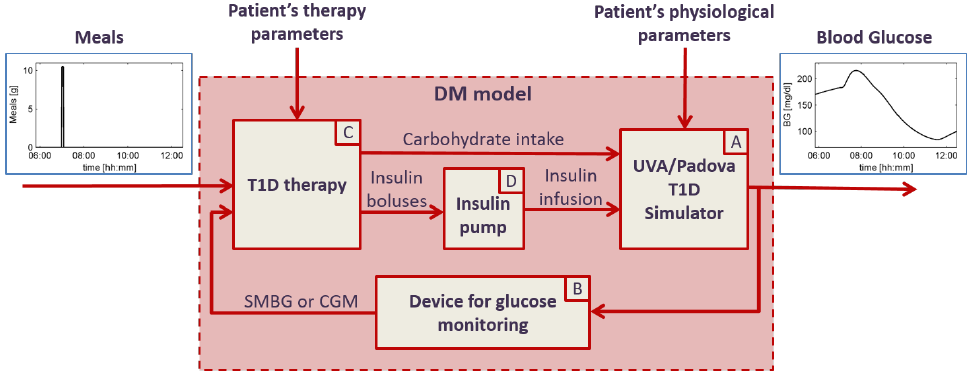
Figure 3. The T1D-DM model developed to generate ISCT to test SMBG-based or CGM-based treatment